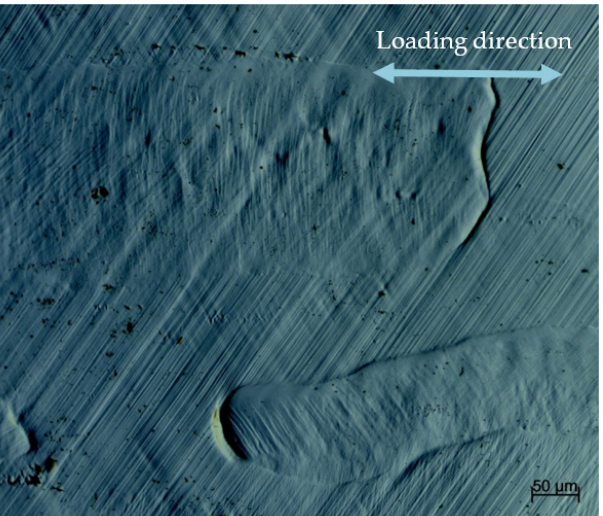
Figure 1. Typical slip bands formed in Aluminum alloy after 4.3% straining observed with differential interference contrast microscopy.